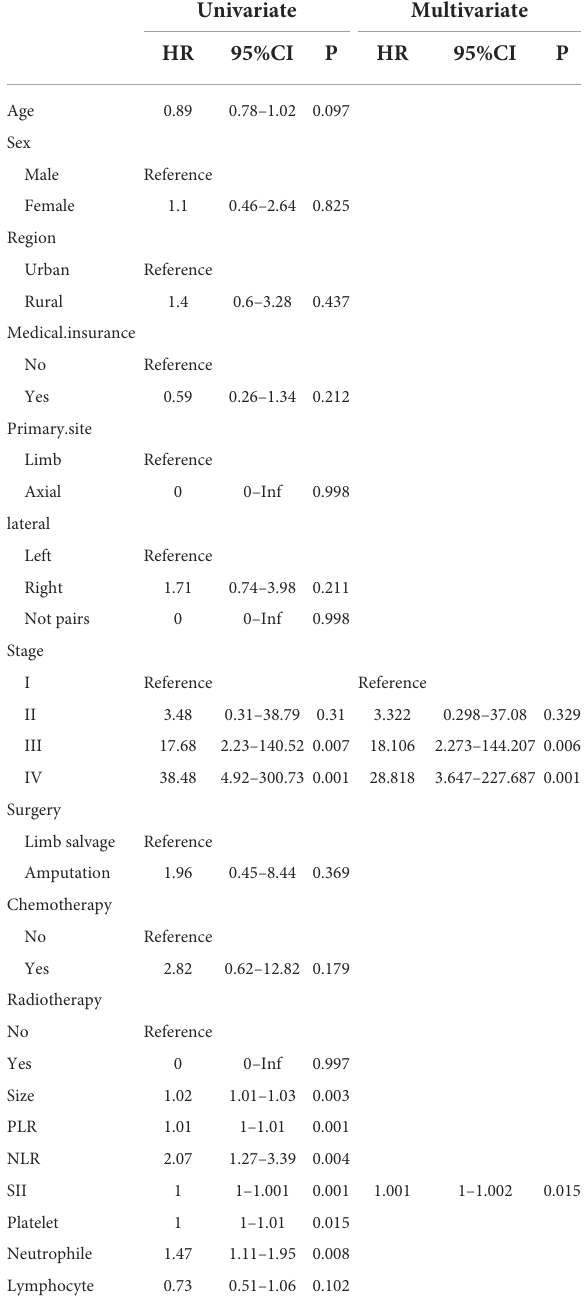
TABLE 3 Univariate and multivariate analyses of CSS.